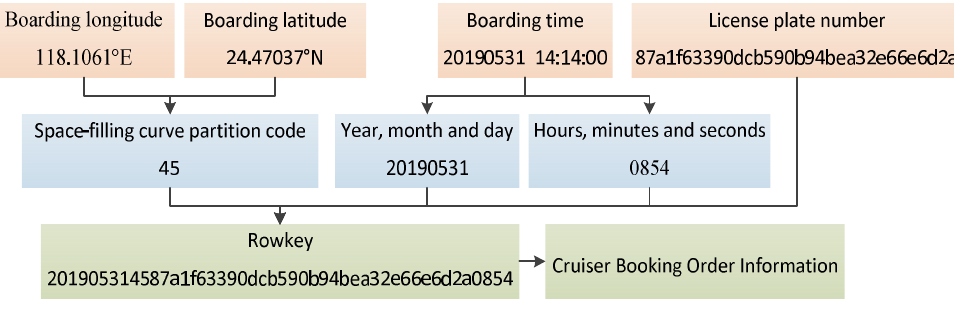
Figure 9. RowKey coding structure.